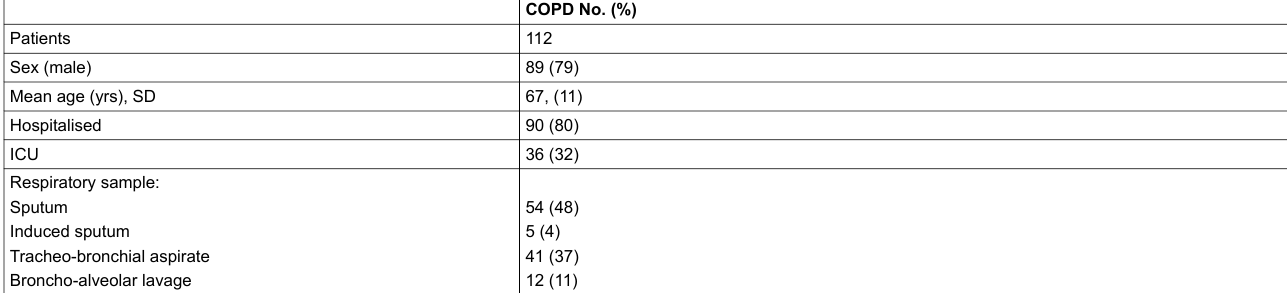
Table 2: Characteristics of COPD study population with P. aeruginosa identified in a respiratory sample.